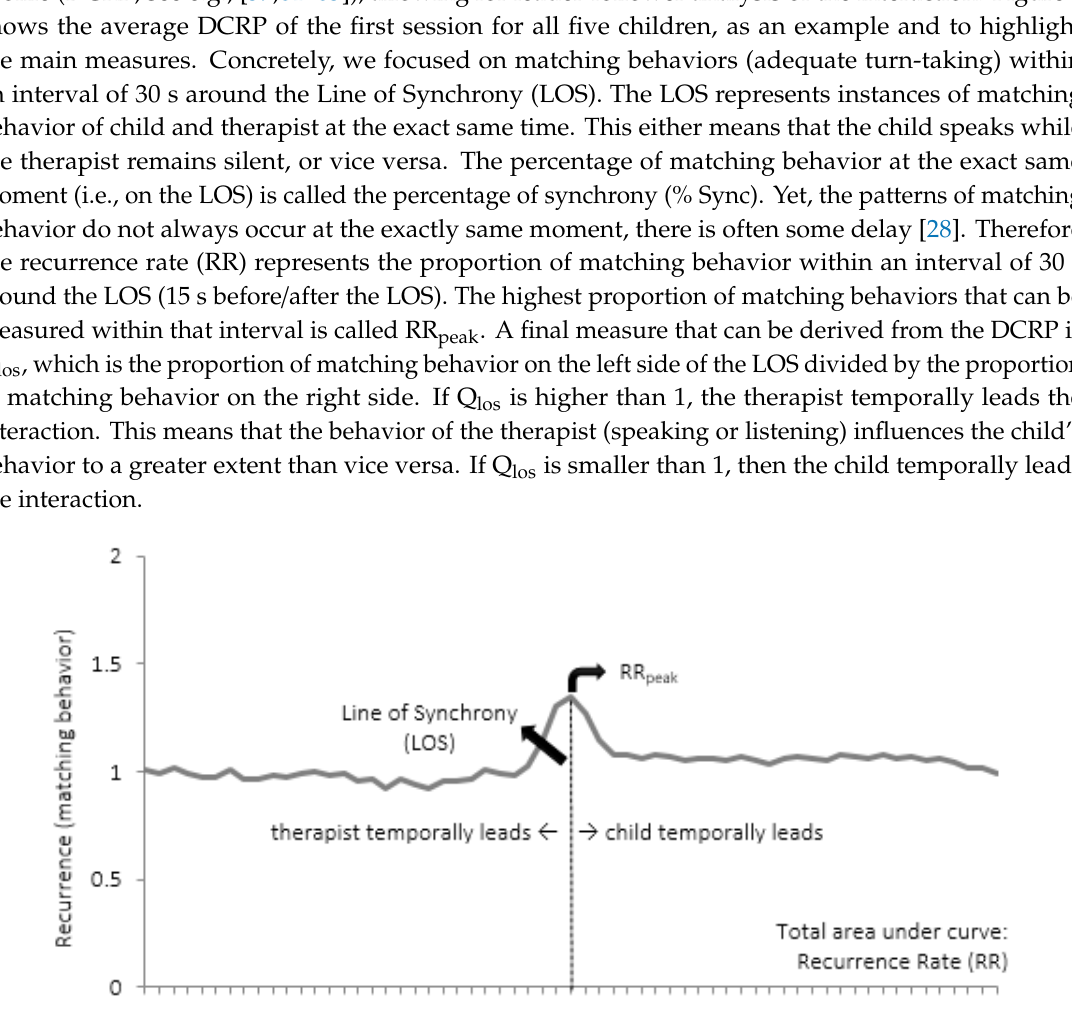
Table 2. Total time of spoken language measured in seconds and DCRP measures for the five cases.